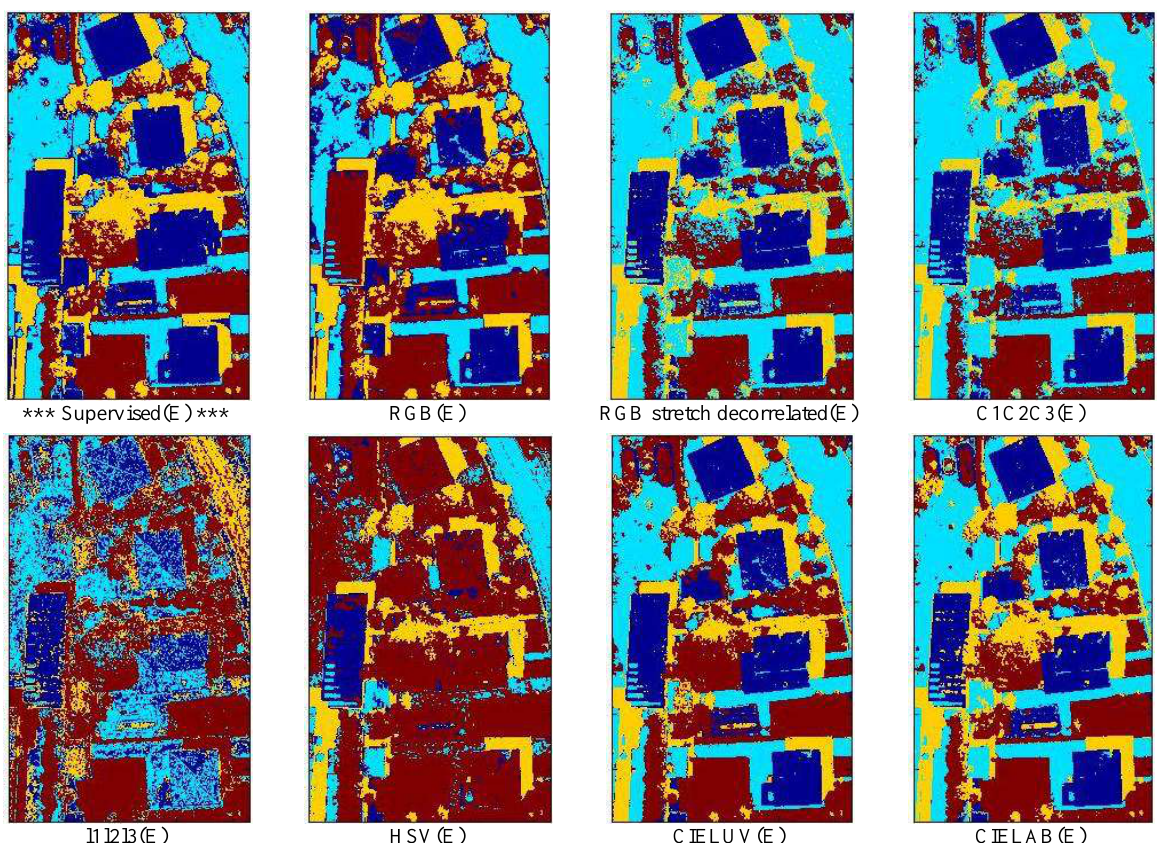
Figure 3: Examples of K-Means classifications of Image 2_2008 at 27 cm with different vector components: blue represents urban areas, cyan identifies streets and bare soil, brown vegetation and yellow shadows. (E) indicates to Euclidean distance.